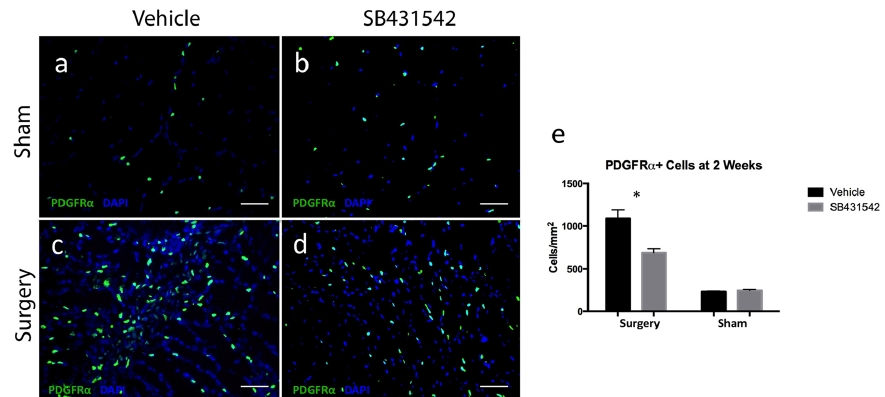
quantification of PDGFR α + cells/mm 2 from 4 representative fields of view imaged at 20X magnification per animal (N = 3/group). * p < 0.05.